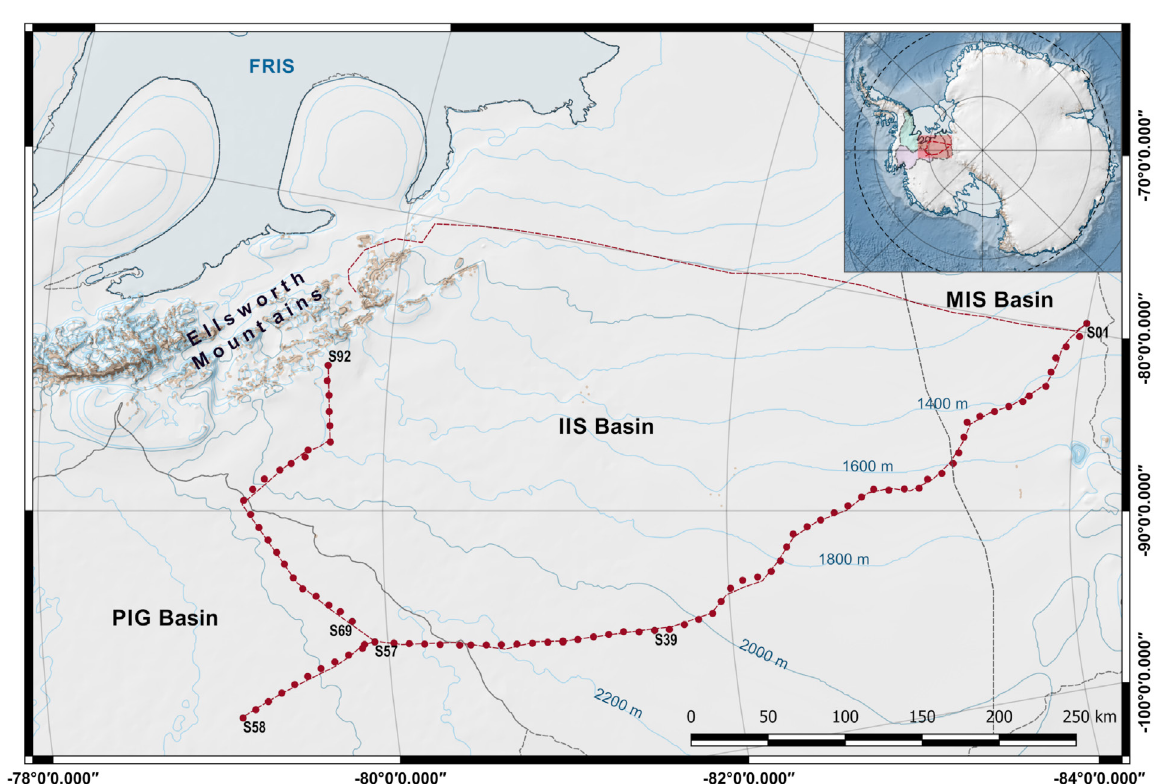
Figure 1. Map showing the route (thin red line) of the 2015 Brazilian traverse on the West Antarctic Ice Sheet (WAIS). Red dots are the surface snow samples sites. The red dashed line is the non-sampled route from Ellsworth Mountains to the Criosfera 1 scientific module site. Gray contours represent the basin boundaries. Blue lines represent terrain contours at every 200 m height. This map is made in QGIS using the Quantarctica 3 Project datasets (Matsuoka et al.